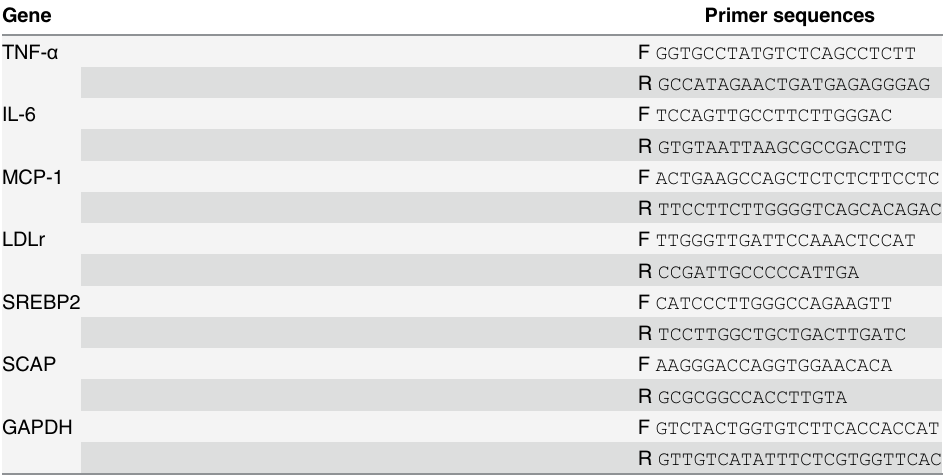
Table 2. Real-time PCR primer